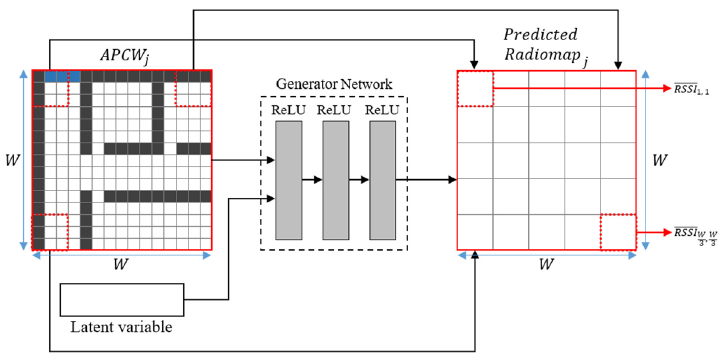
Figure 7. Structure of predicted radio-map.